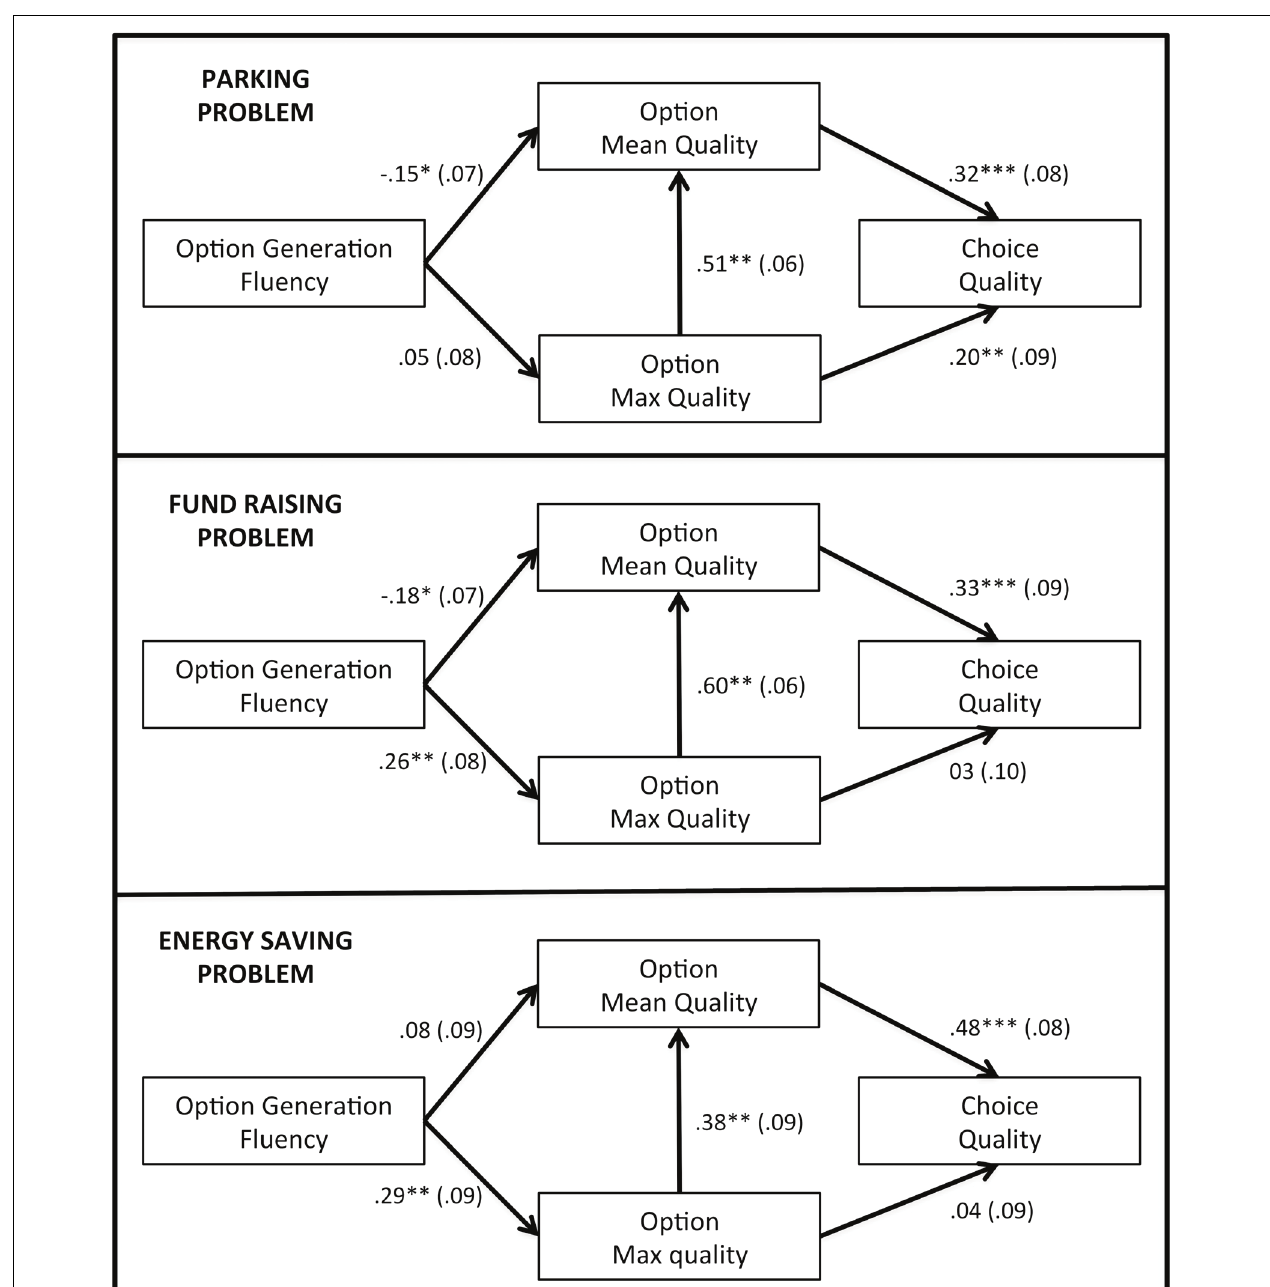
FIGURE 1 | Path analysis model for each problem. Note: Two-tailed significance levels: ∗∗∗ p < 0 . 001; ∗∗ p < 0 . 01; ∗ p < 0 . 05. The standard error for each standardized path coefficient is reported in